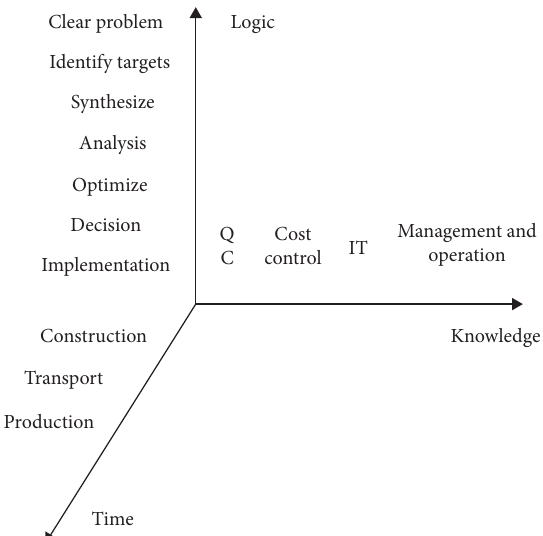
Figure 1: HSM of life cycle cost for prefabricated